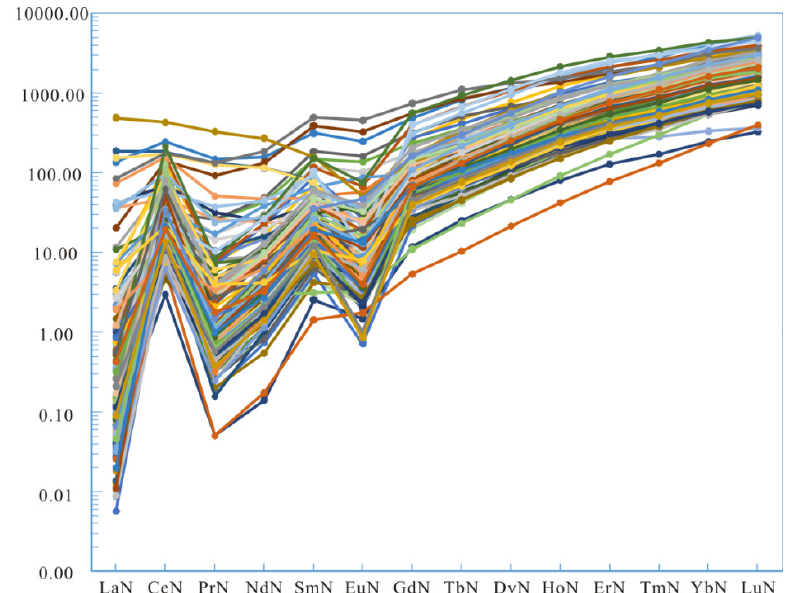
Figure 5. Chondrite-normalized REE broken line patterns of 152 detrital zircons from the Jurassic Zhiluo Formation in the Yongshou area (Broken lines with different colors, and data are replotted from the original source and normalized to the chondrite values of W.V. Boynton [74]).